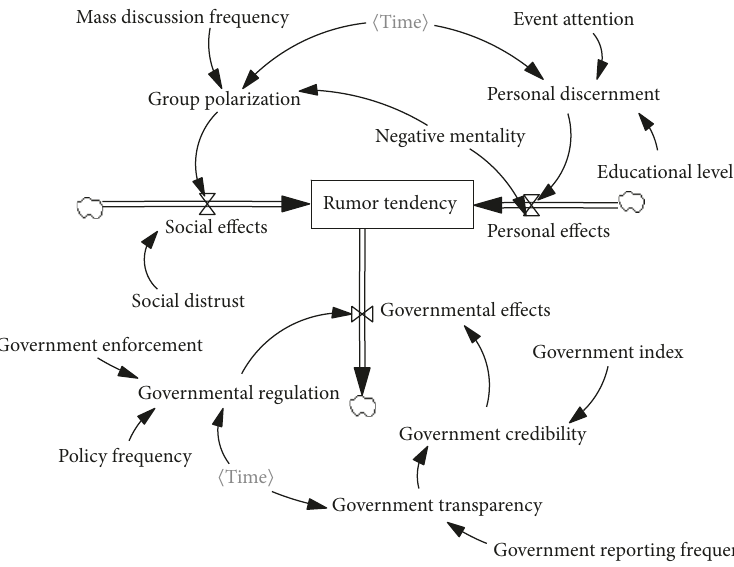
Figure 5: Flow-stock diagram of the disinformation behavior